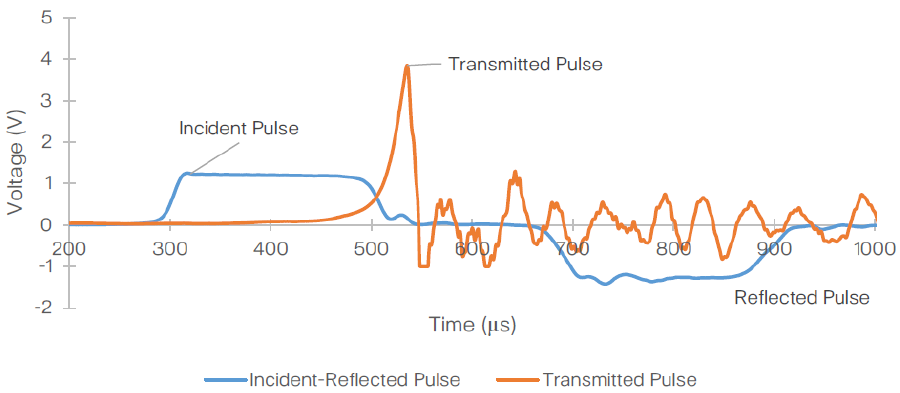
Figure 9. Representative raw signals obtained from one of the 2100/s strain rate following the SHPB experiment conducted on T700/PA6.6 specimen.